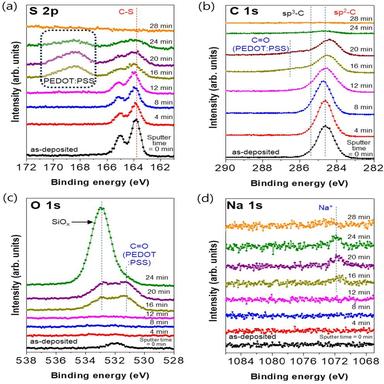
(a) S 2p, (b) C 1s, (c) O 1s, and (d) Na 1s XPS depth profiles of P3HT:PC71BM/PEDOT:PSS/SiO2 structure obtained in conjunction with Ar gas cluster ion beam sputtering. Sputtering time intervals = 4 min.